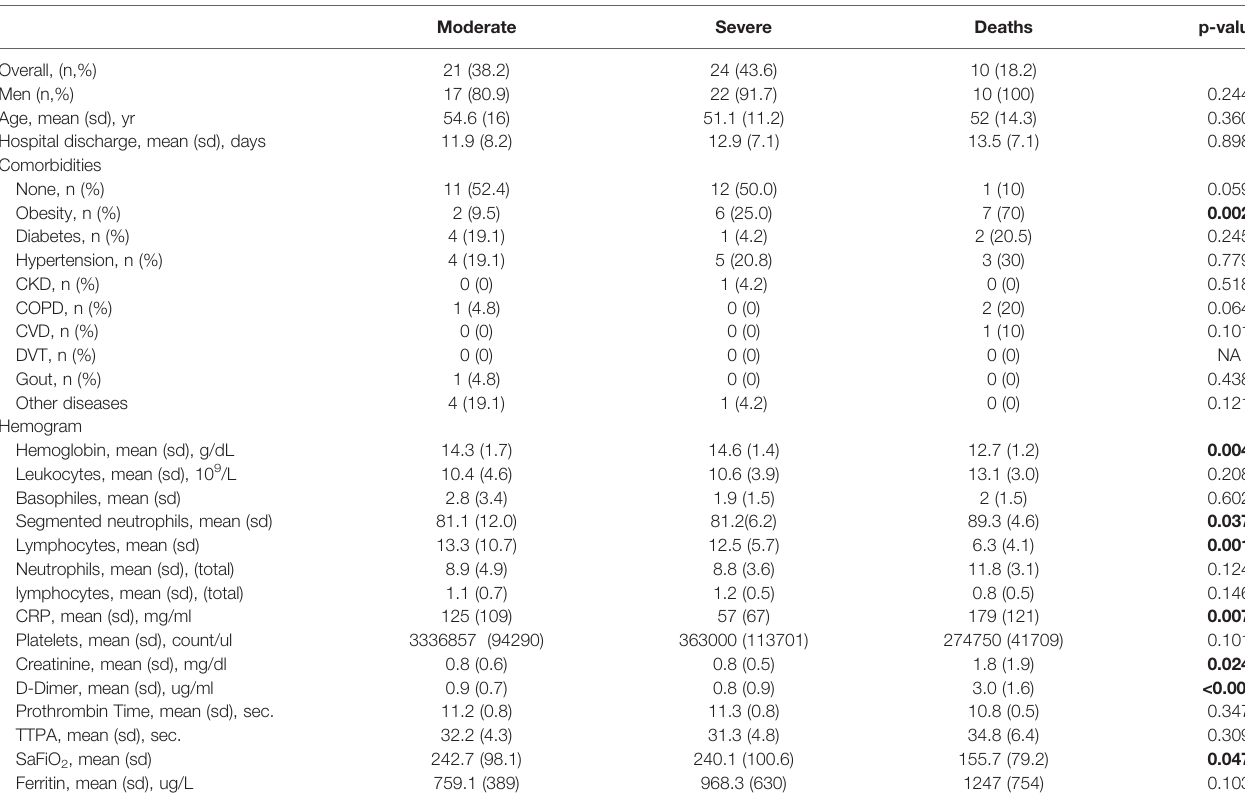
TABLE 1 | Characteristics of the study population.